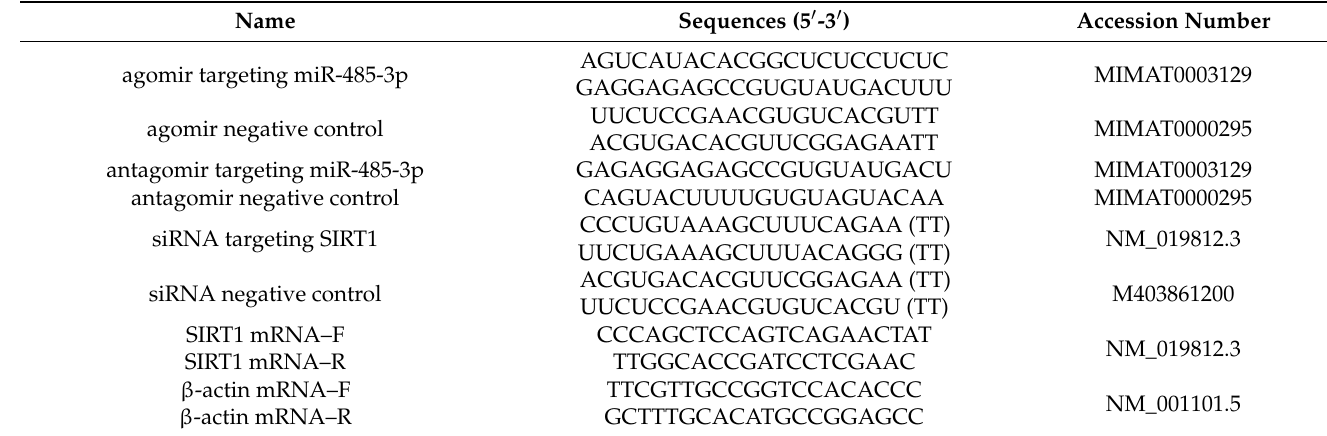
Table 1. Sequences of agomirs, antagomirs, mRNA and